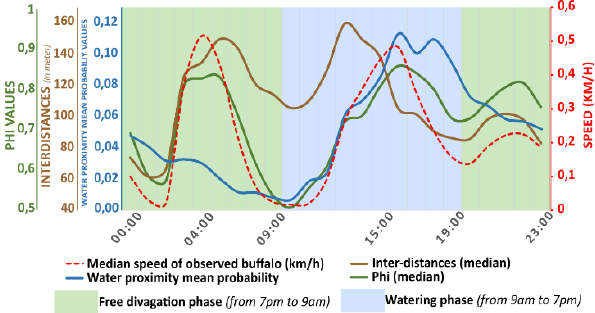
Figure 3. Mean probabilities of the observed buffalo to be nearby (< 100m, shaded zone) surface water as a function of the time of the day (blue line), superimposed to the median speed of the observed buffalo (red dashed line), the median interdistance (brown line) and the phi values (green line)